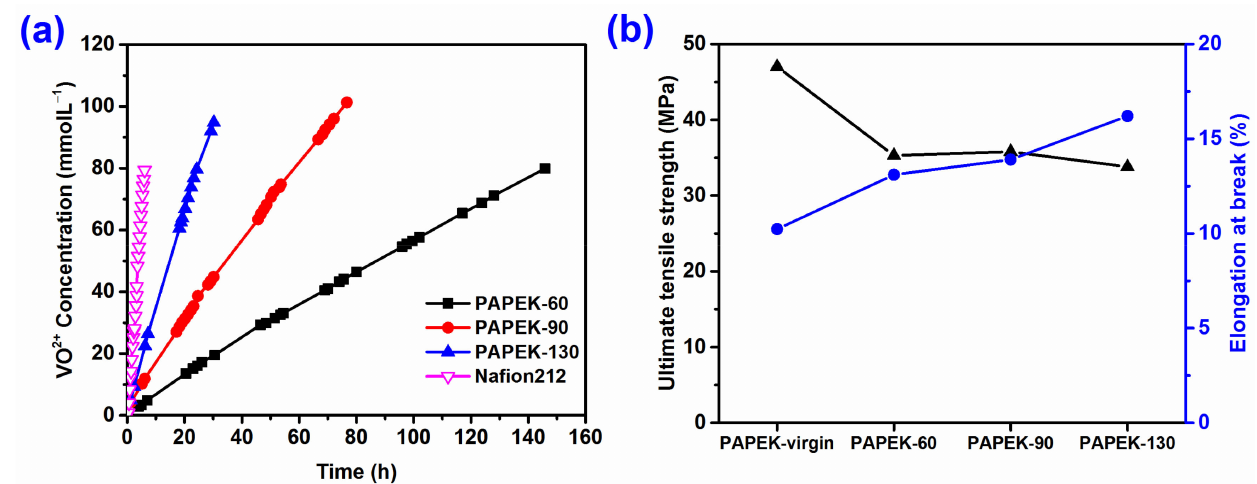
Figure 5. VO 2+ permeability ( a ) and mechanical strength ( b ) of PAPEK membranes.